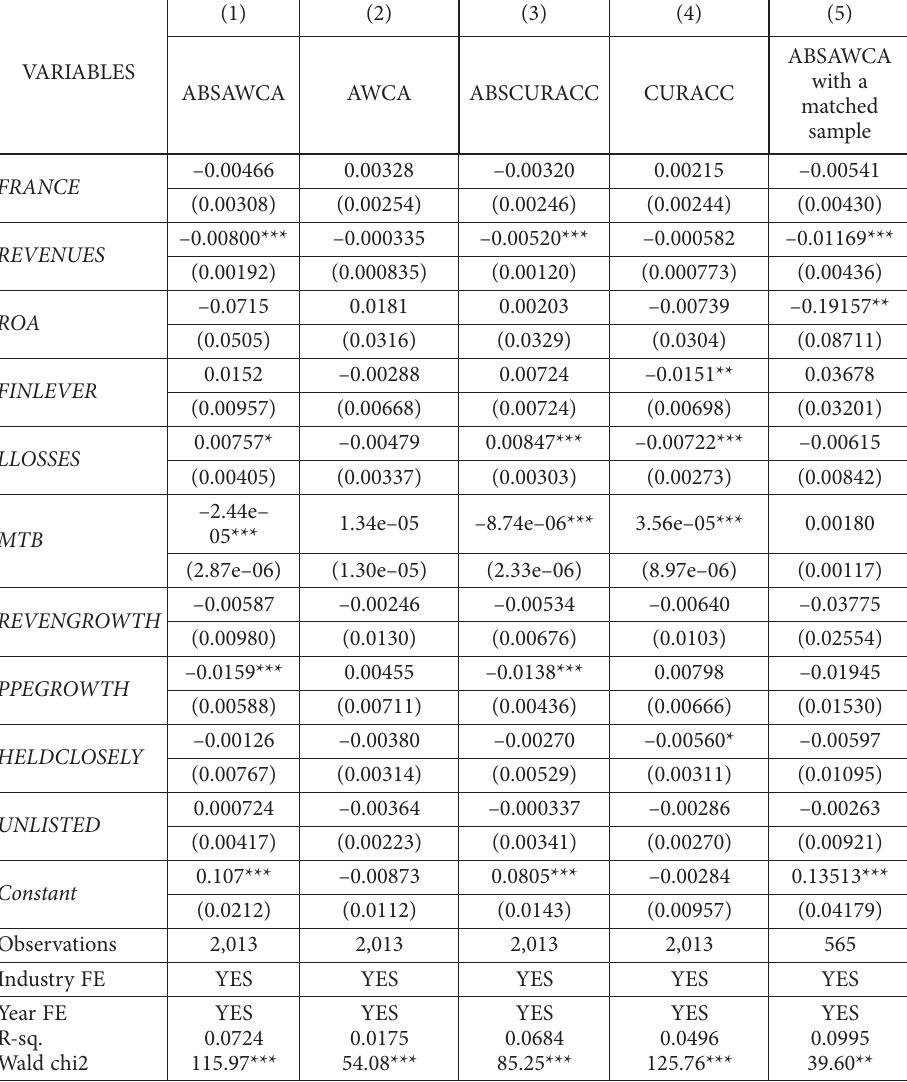
Table 2. The relationship between joint audit and discretionary accruals. Estimations with the whole sample (Columns (1) to (4)), and with a matched sample (Column